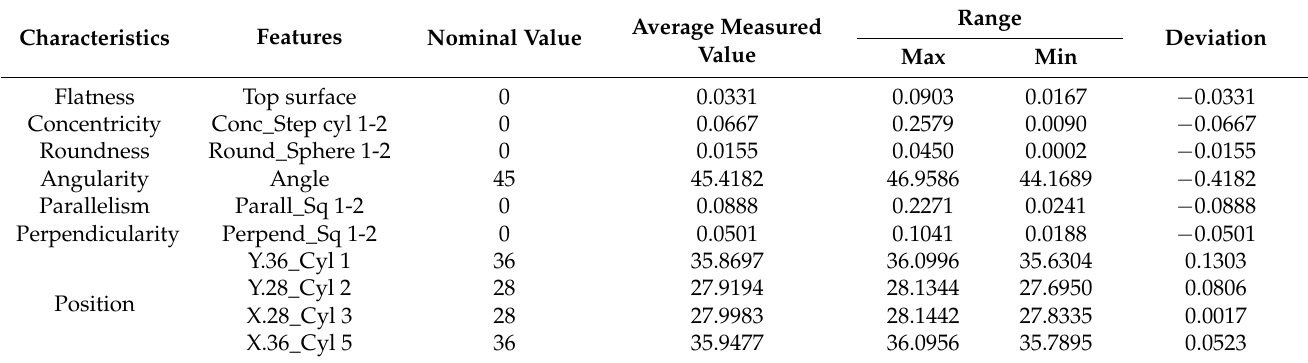
Table 19. Casting measurement results for geometric characteristics, in mm.